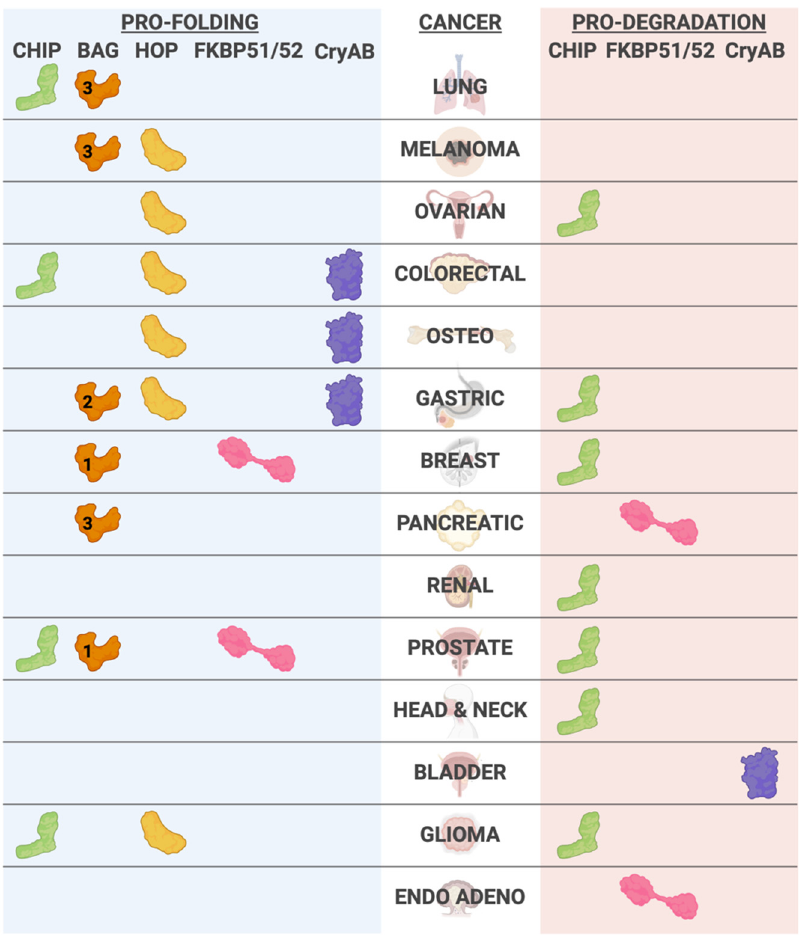
Figure 4. Co-chaperones and their implications across the cancer spectrum. Co-chaperones can associate with pro-folding and pro-degradation activities towards chaperone substrates. The co-chaperones listed indicate both the cellular triage condition, pro-folding (blue) or pro-degradation (orange), as well as the type of cancer (ENDO ADENO- endometrial adenocarcinoma, OSTEO- osteosarcoma). When appropriate, we included the specific BAG family member identifier; however, we did not indicate BAG2 associations with esophageal, oral, and thyroid cancer.